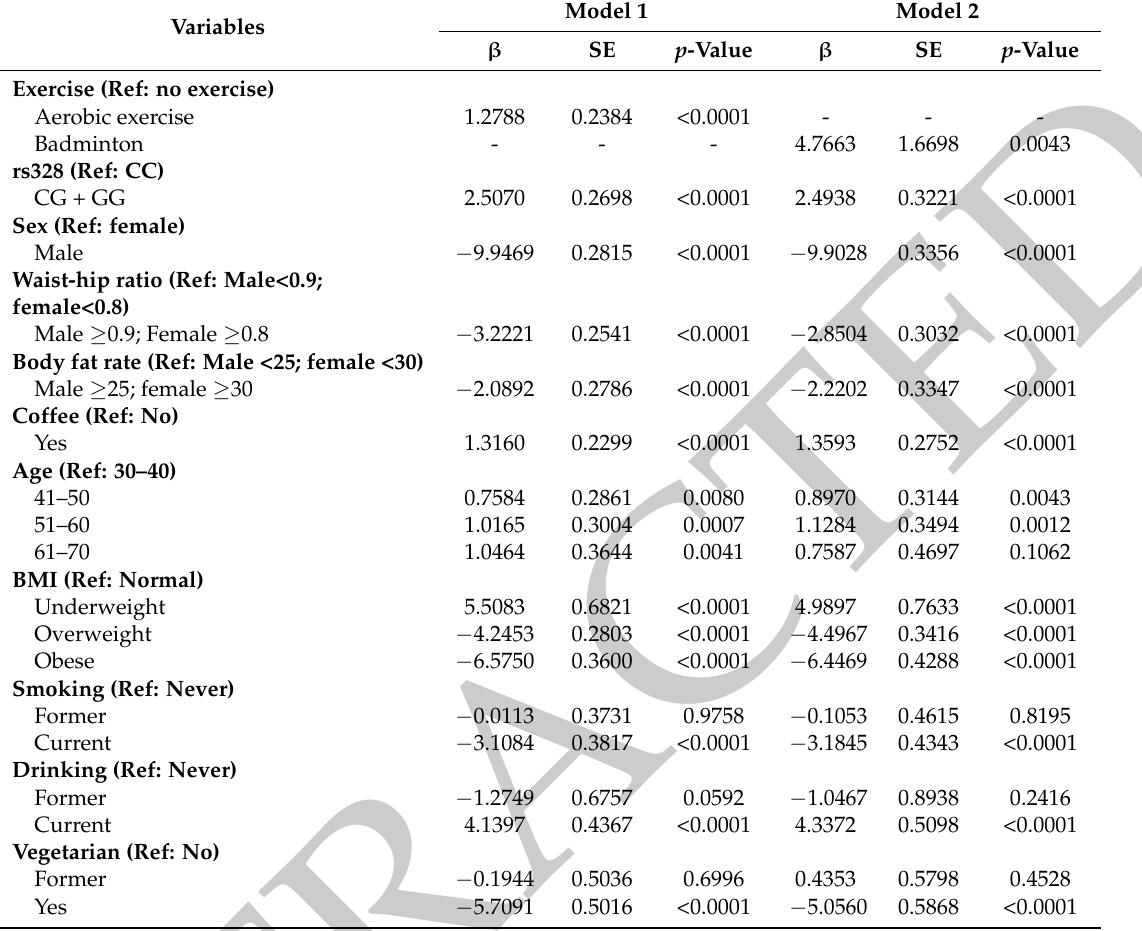
Table 2. Association of high-density lipoprotein (HDL) with aerobic exercise (model 1) and badminton (model 2).